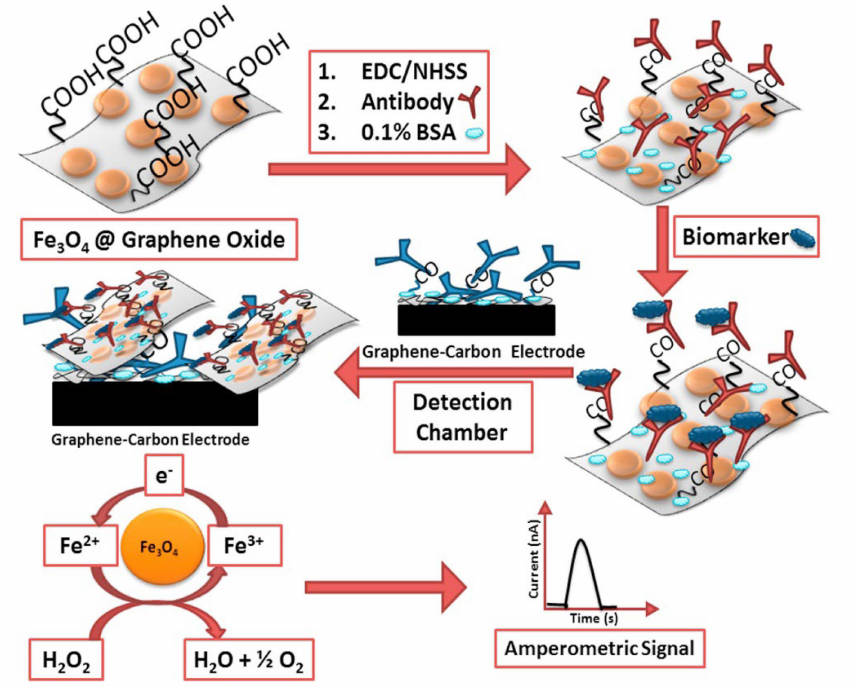
Figure 15. Schematic illustration of the experimental protocol including the preparation of param- agnetic composite (Fe 3 O 4 @GO), immobilization of detection antibodies on the composite surface, blocking with BSA, binding of antigen biomarker with antibody, interaction between the modified composite and electrochemically reduced graphene oxide (ERGO)-carrying secondary antibody- coated electrode, and measurement by using amperometry. Reprinted with permission from Ref.